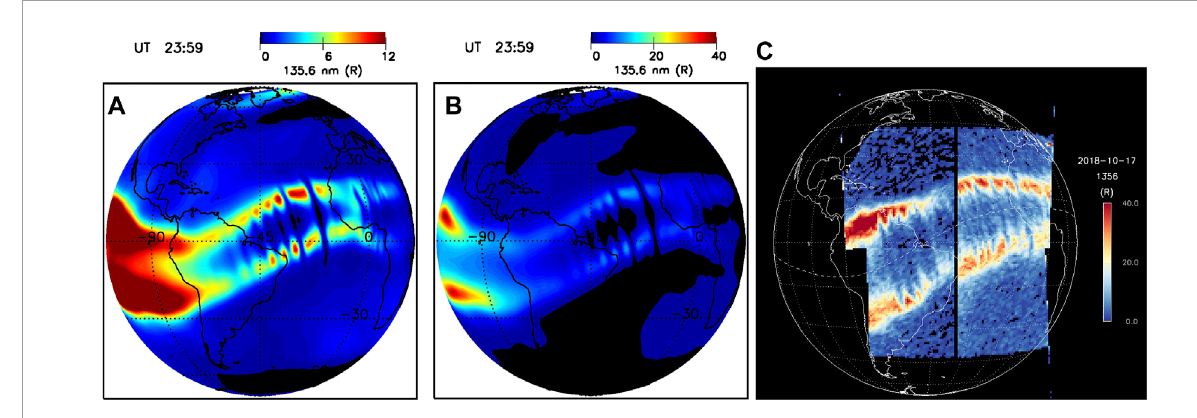
FIGURE 6 Comparison of 135.6 nm emissions from the simulation for the March case (A , B) and GOLD emission data (C) observed from geosynchronous orbit (Eastes et al., 2019).